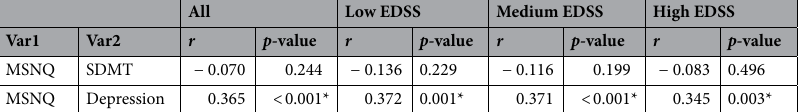
Table 2. Pearson correlations in the different EDSS subgroups. Correlations that are significant (with Bonferroni correction, p < 0.05/8) are marked with *. EDSS Expanded Disability Status Scale, MSNQ Multiple Sclerosis Neuropsychological Questionnaire, SDMT Symbol Digit Modalities Test.